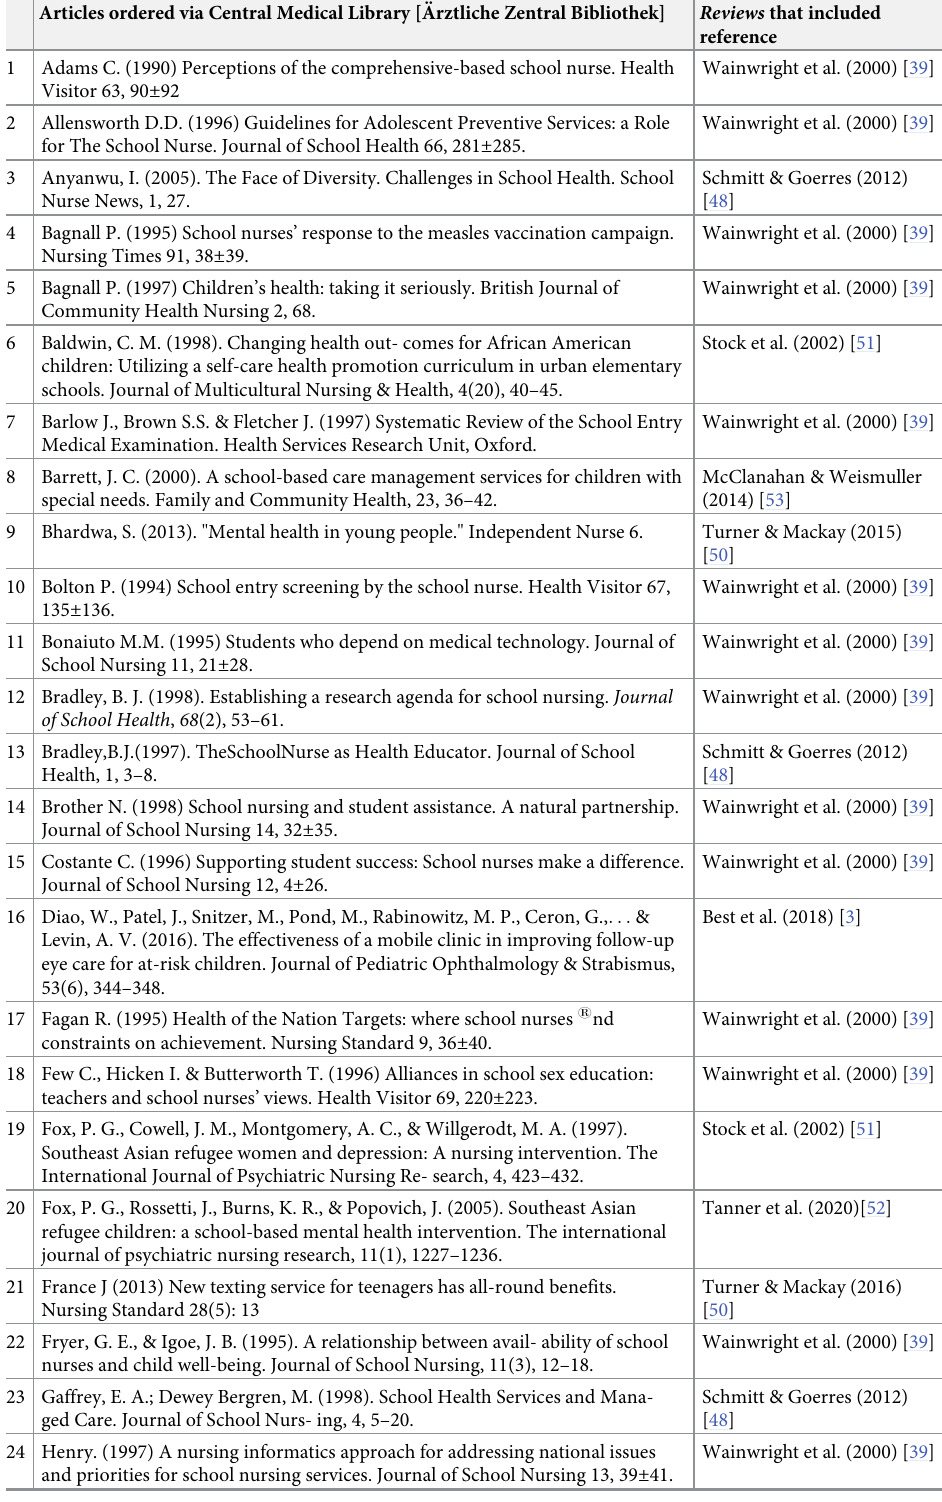
Table 6. Primary studies ordered via the central medical library. Articles ordered via Central Medical Library [A¨rztliche Zentral